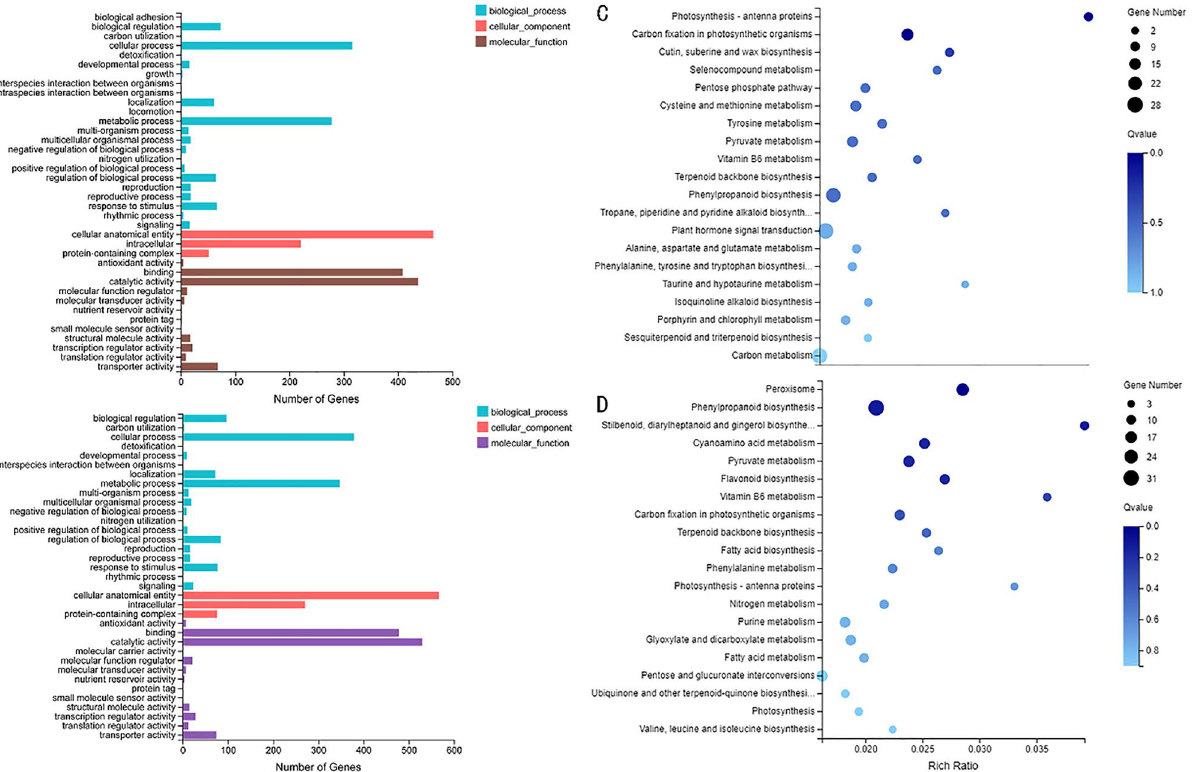
Figure 2. (A) GO functional classification of differentially expressed genes in L1 (green leaf), and L2 (the leaves with purple edges) in S. miltiorrhiza . (B) GO functional classification of differentially expressed genes in S1 (green stem), and S2 (purple stem). (C) Scatter plots of the KEGG pathway enrichment statistics in L1–L2. (D) Scatter plots of the KEGG pathway enrichment statistics in S1–S2.